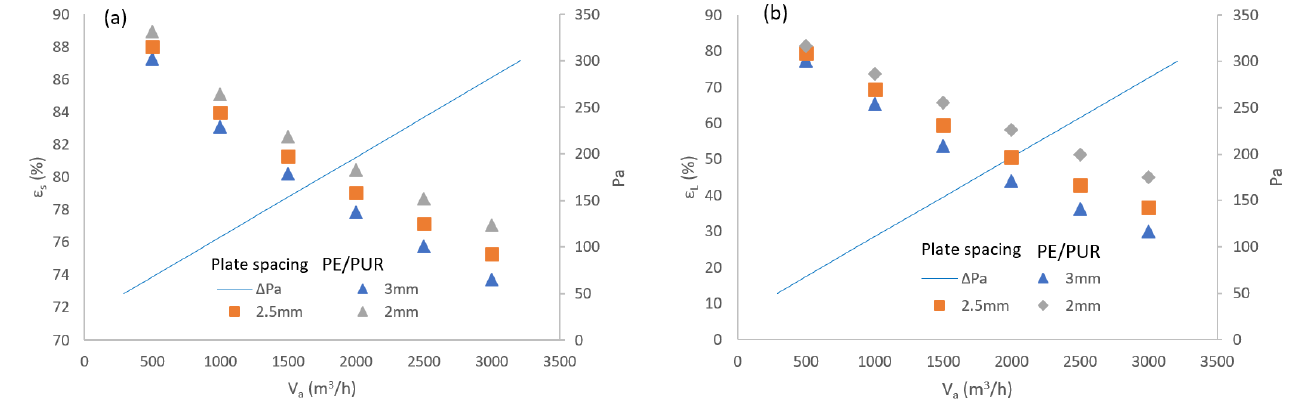
Figure 14. Effectiveness with variable plate spacing ( a ) Sensible effectiveness; ( b ) Latent effectiveness.